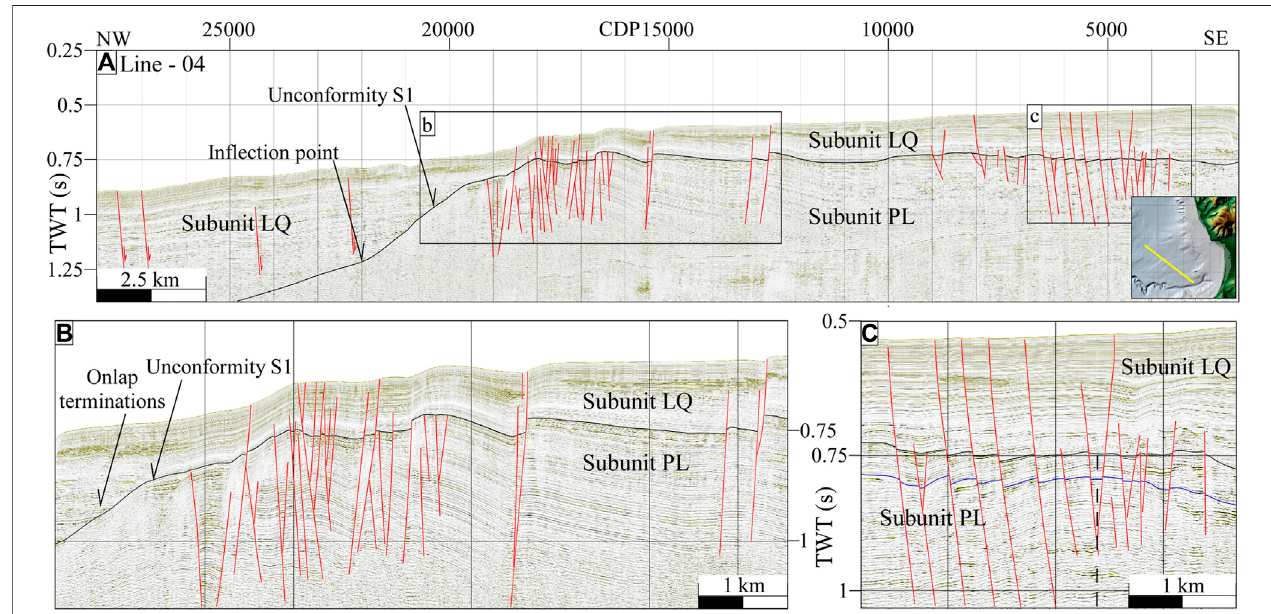
FIGURE6|(A) Seismicpro fi le “ Line — 04 ” anditsinterpretation.Insetshowsthelocationofthepro fi le. (BandC) PartsofLine — 04thatshowhigh-angletrastensive faults.Bluelinemarksthesouth-westernmostpartoftheanticlineassociatedtothedevelopmentoftheMaidaRidge.Blackdashedlinerepresentstheanticlineaxis.Red lines indicate transtensional faults. PL and LQ are the subunits recognised in the Plio Quaternary deposits.